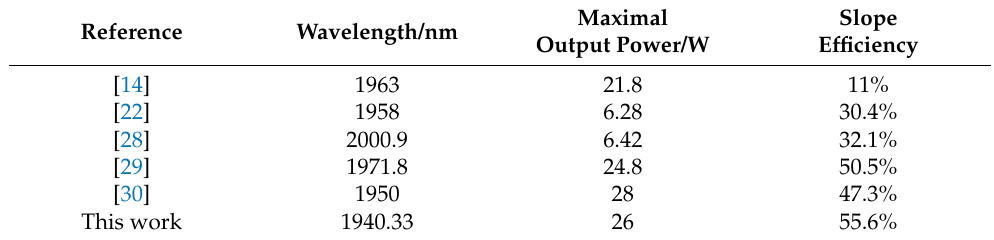
Table 1. Technical indicator comparison of our work with other proposed high power